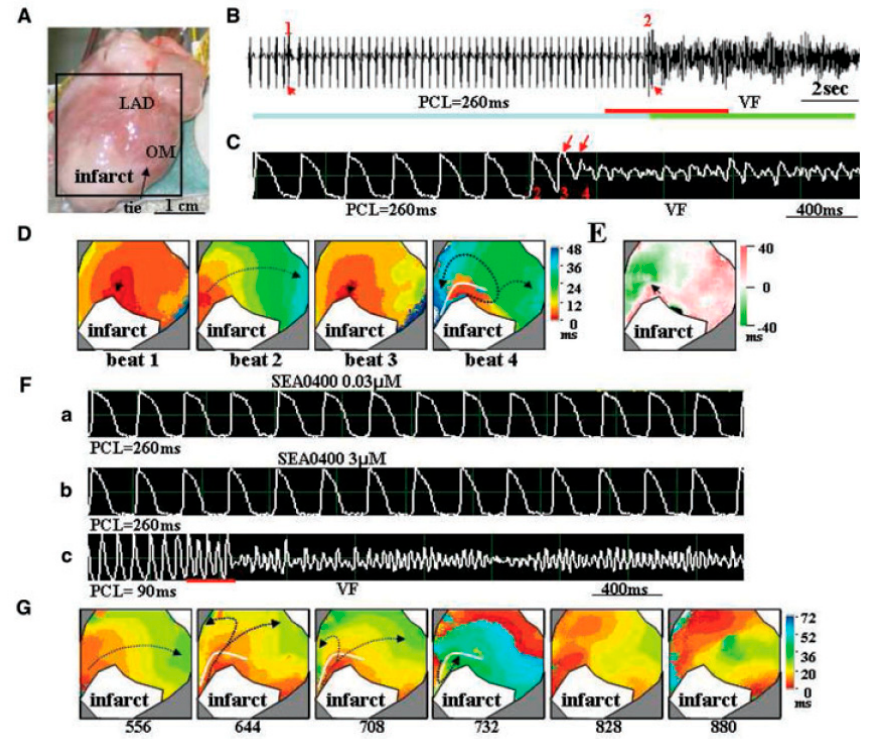
Figure 8. Effect of SEA-0400 on ventricular arrhythmias measured by optical mapping. ( A ): Mapped region; ( B ): ECG measurement. Red arrows indicate ventricular premature beats; Numbers indicate the number of beats ( C ): action potentials corresponding from the red bar in panel. Red arrows indicate ventricular premature beats; ( D ): isochronal map showing beat marked in ( B ) (beat 1) and in panel ( C ) (beat 2–4); ( E ): APD 80 map with nodal line; ( F ): action potential tracing: a and b—no arrhythmia was observed in the presence of 0.03 and 3 µ M SEA-0400 at 260 ms pacing cycle length c—at 90 ms pacing cycle length fibrillation was observed in the presence of 3 µ M SEA-0400; ( G ): isochronal map corresponding to ( F c). Numbers indicate the time of data acquisition. Frames 708 and 732 illustrate formation of re-entrant wavefront, 828 and 880 depict multiple wavefronts (Reprinted with permission from Ref. [76]. 2022,